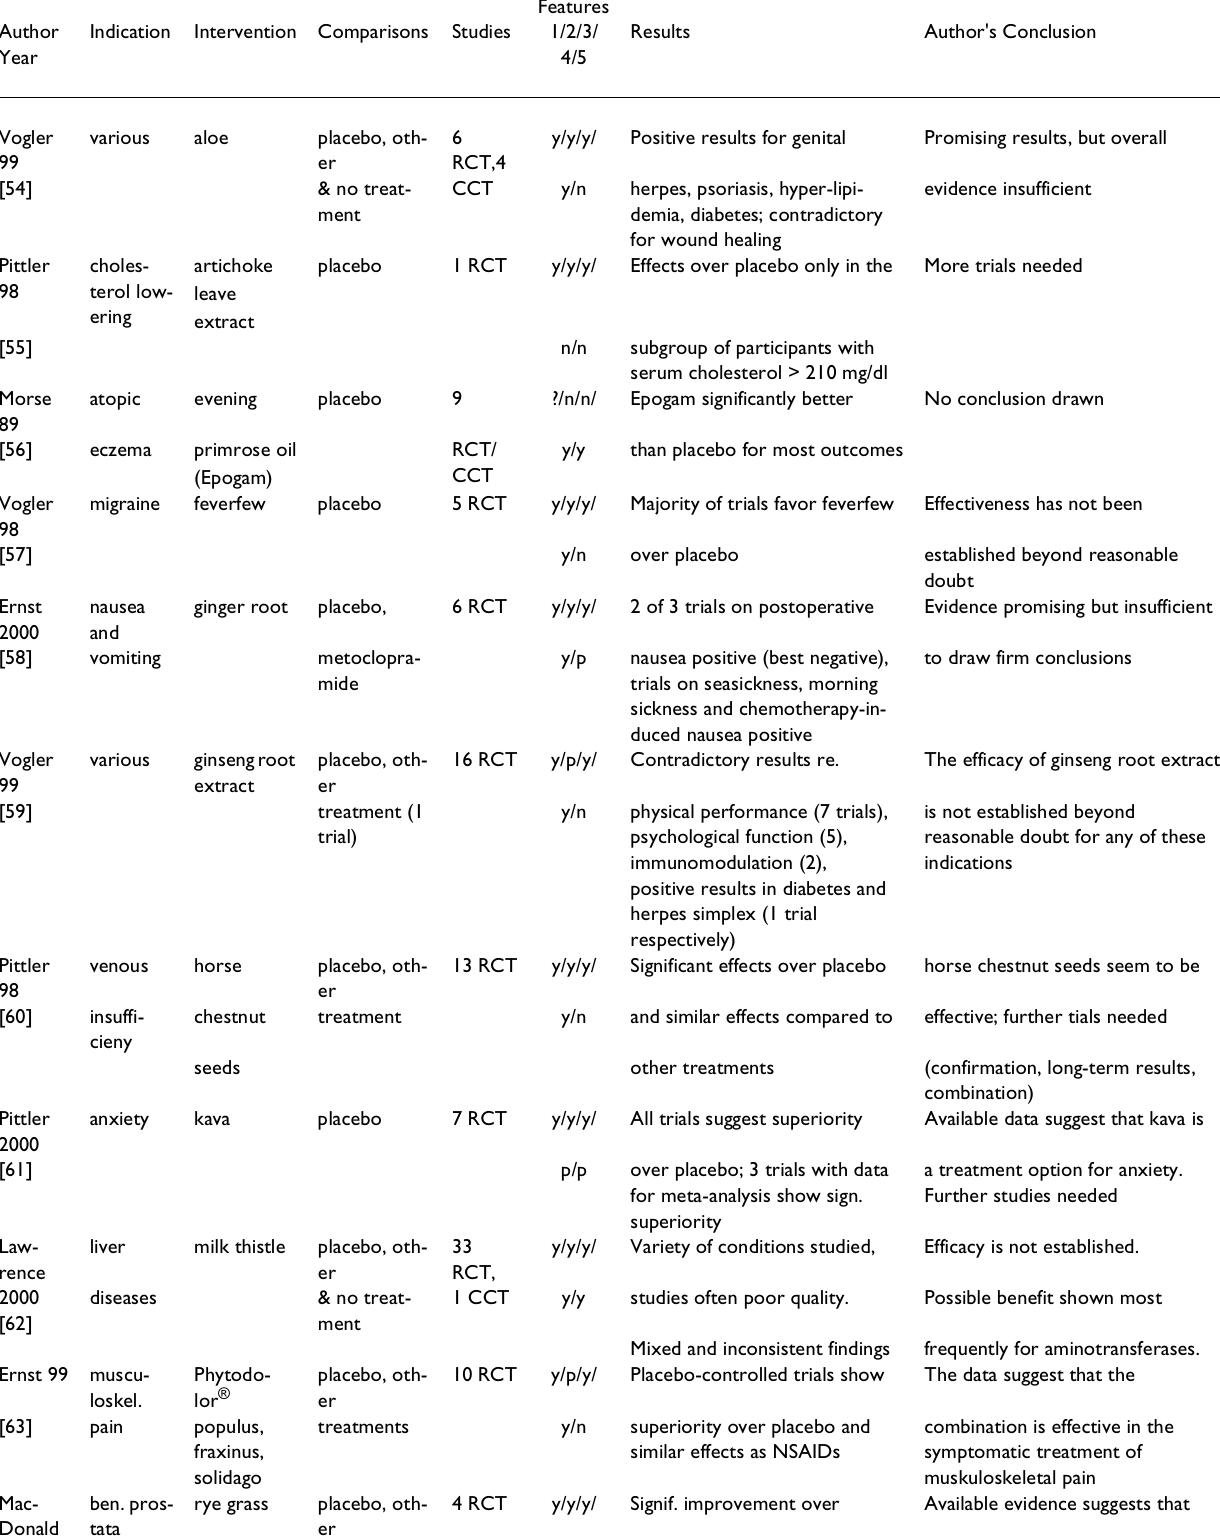
Table 4: Systematic reviews of clinical trials of herbal